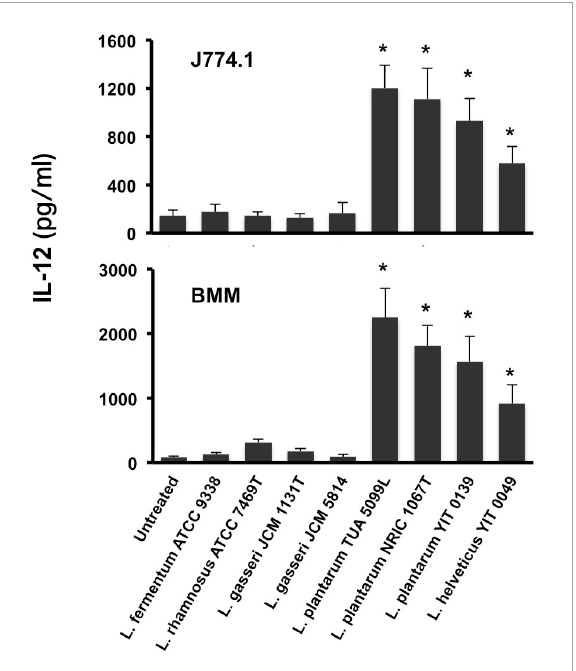
FIGURE2 IL-12 secretion from macrophages stimulated with ICWs of lactobacilli. ICWs were prepared from heat-killed cells of several lactobacilli by SDS, pronase, and nuclease treatments. J774.1 cells (5 × 10 5 /ml, upper panel) and BMMs (5 × 10 4 /ml, lower panel) were cultured with 10 µ g/ml of ICWs for 24 h and IL-12 secreted in the culture supernatant was determined. Each bar is the mean ± SE for five independent experiments. The results were reproducible for at least three independent ICW preparations for each strain. * P < 0.01 vs. untreated